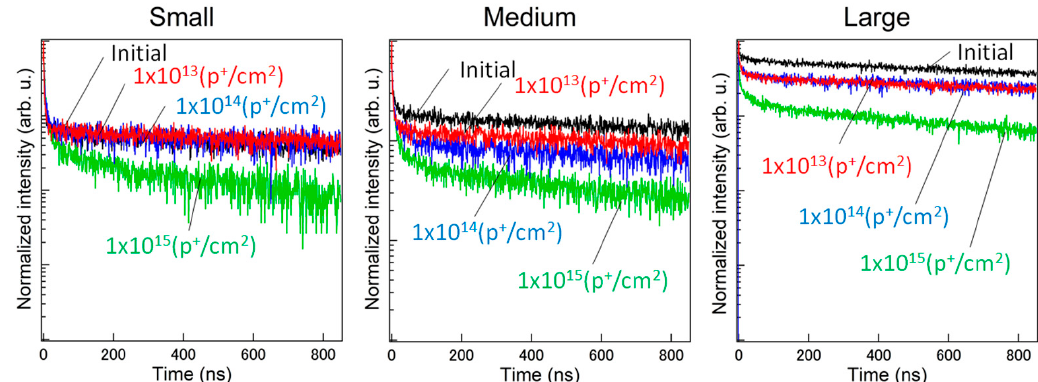
Figure 13. Effect of 50 keV proton irradiation on normalized TRPL decay curves for small grain (~240 nm) sample, medium grain (~340 nm) sample, and large grain (~690 nm) sample. (Reprint Figure 2 in p. 6992 of S. Kanaya et al., J. Phys. Chem. Lett. 10(2019) 6990–6995) .